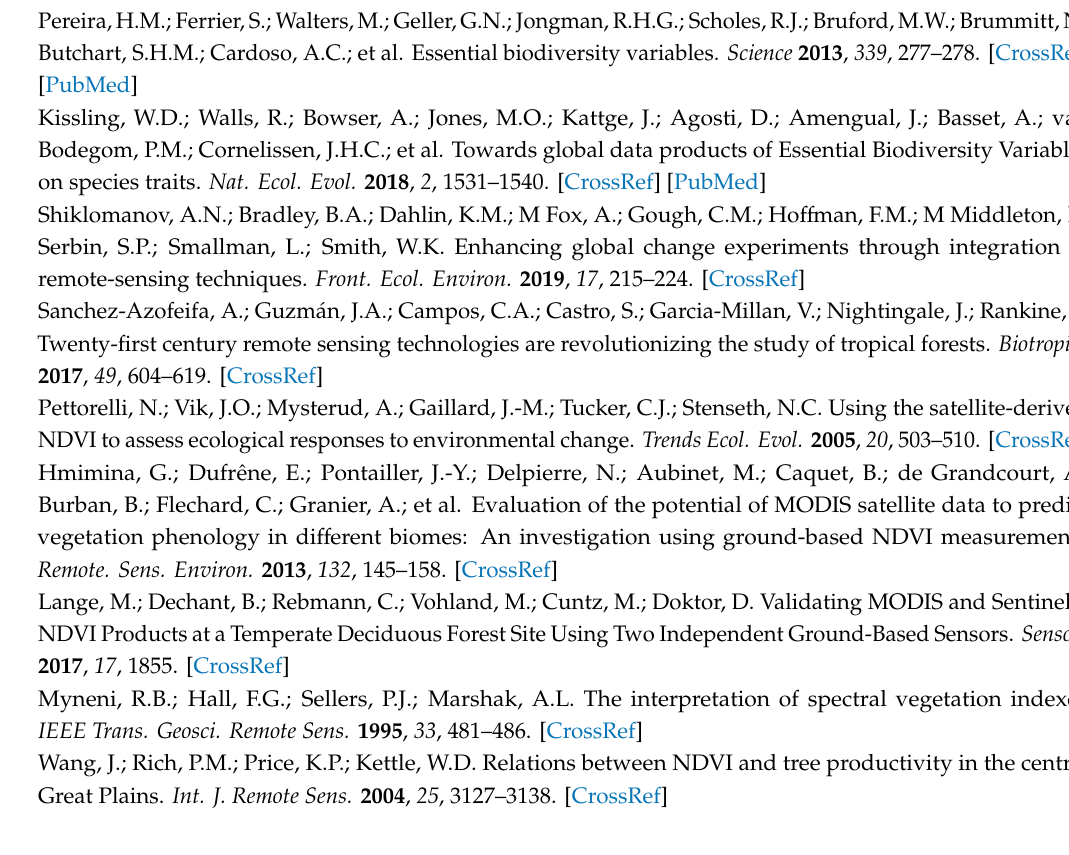
Figure S1: Unprocessed and processed time series of Normalized Di ff erence Vegetation Index (NDVI) derived from MODIS (Aqua and Terra) at four Tropical Dry Forests distributed along the Americas. Figure S2: Unprocessed and processed time series of Normalized Di ff erence Vegetation Index (NDVI) derived from PROBA-V at four Tropical Dry Forests distributed along the